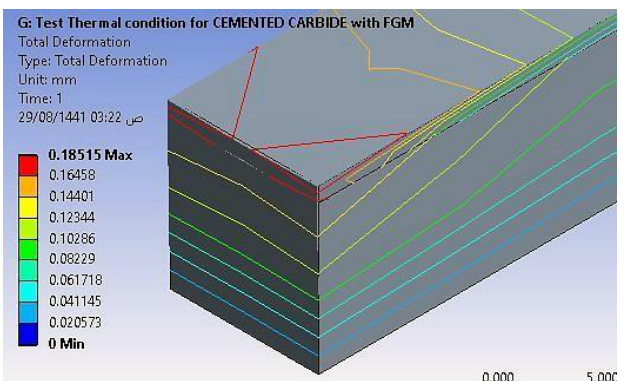
Fig. 17. Total deformation (0.18515 mm) at 1000 °C thermal